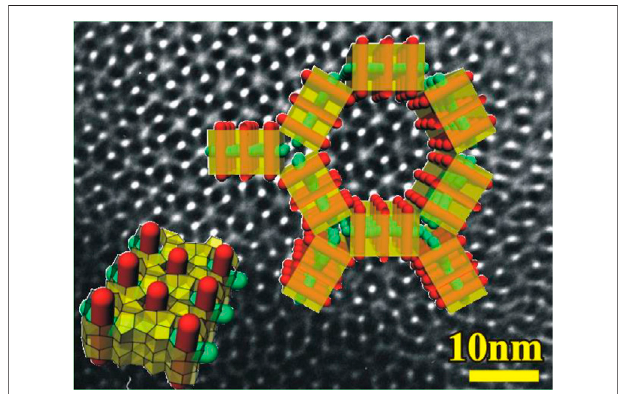
FIGURE 3 | Tiling patterns of nanoslabs in zeotile-1 superimposed on a transmission electron microscopic (TEM) image (adapted with permission from Martens et al.,